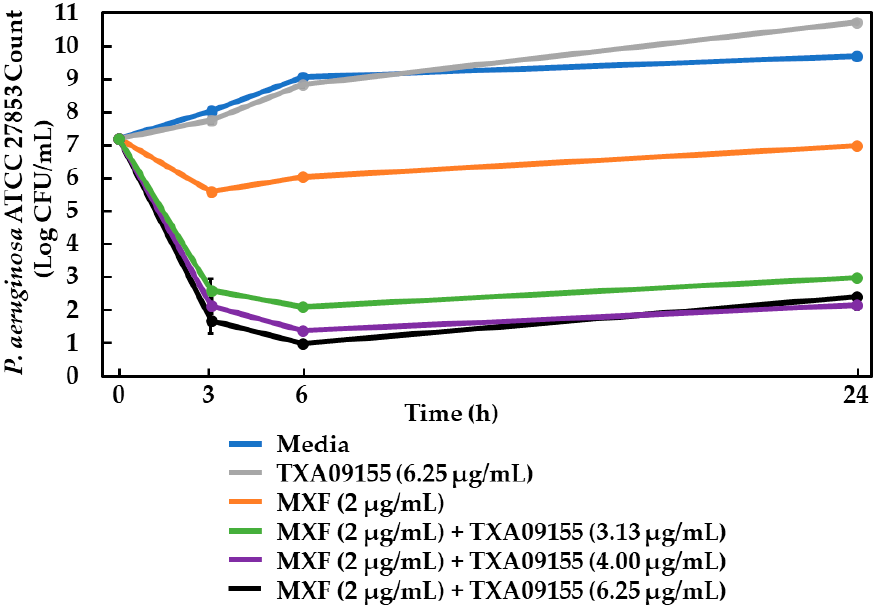
Figure 6. Time-kill kinetics of moxifloxacin (MXF) alone and in combination with different concentra- tions of TXA09155 on P. aeruginosa . Values expressed as mean log 10 of CFU/mL. Error bars represent standard deviation.